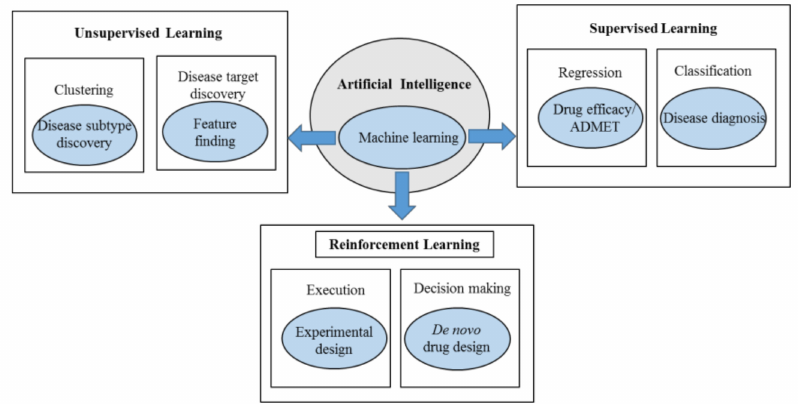
Figure 2. The applications of artificial intelligence (AI) and its subset (machine learning) in disease diagnosis and drug